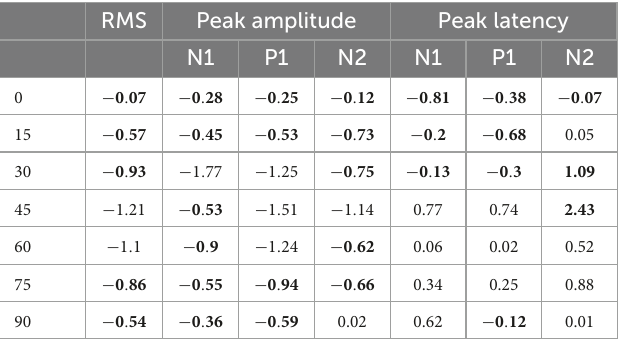
TABLE 1 Effect size for the comparisons between the two groups.